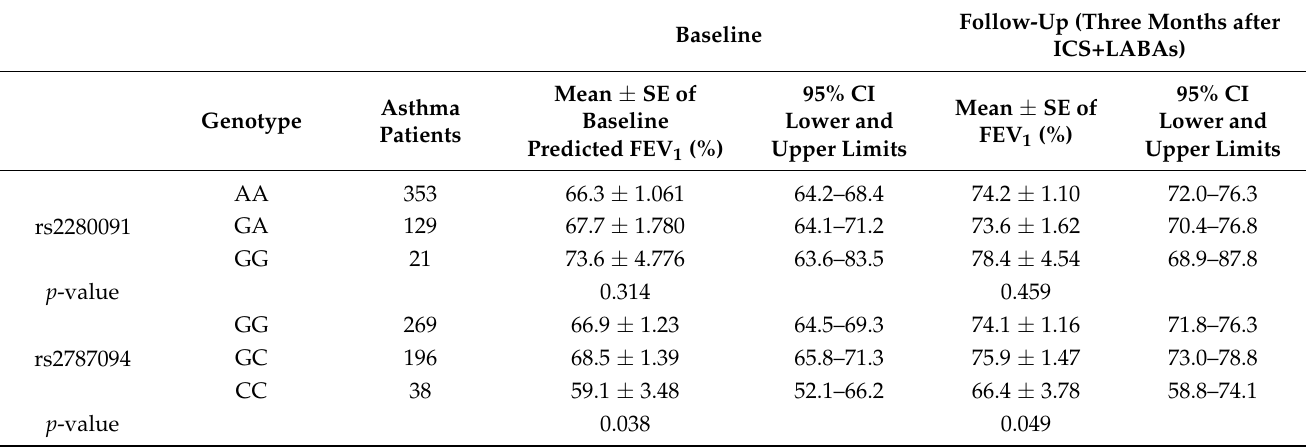
Table 4. Predicted baseline FEV 1 (%) and FEV 1 (%) improvements after three months of inhaled corticos- teroids (ICS) and long-acting beta-agonists (LABAs) with various SNPs of ADAM33 in asthma